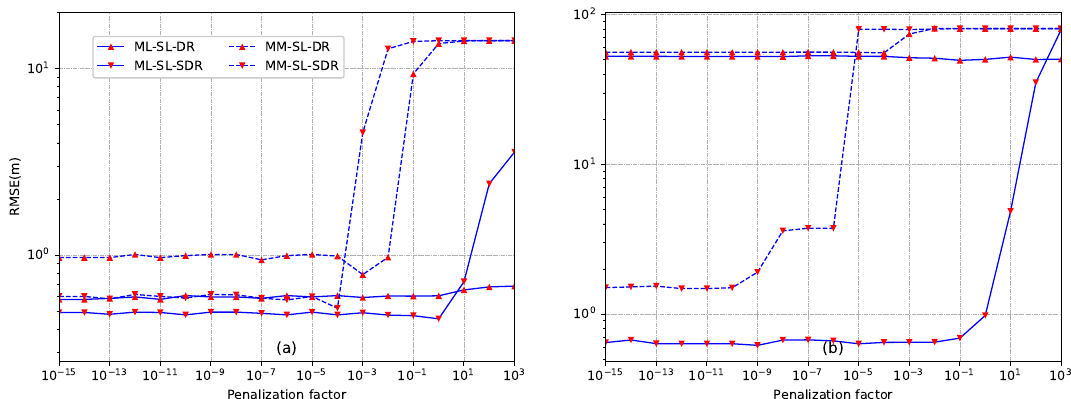
Figure 4. Comparison of the proposed source localization methods with different penalization factors. ( a ) the source is inside the convex hull of the sensor nodes ( y = [ 10,10 ] T ); ( b ) the source is outside the convex hull of the sensor nodes ( y = [ 10,80 ] T